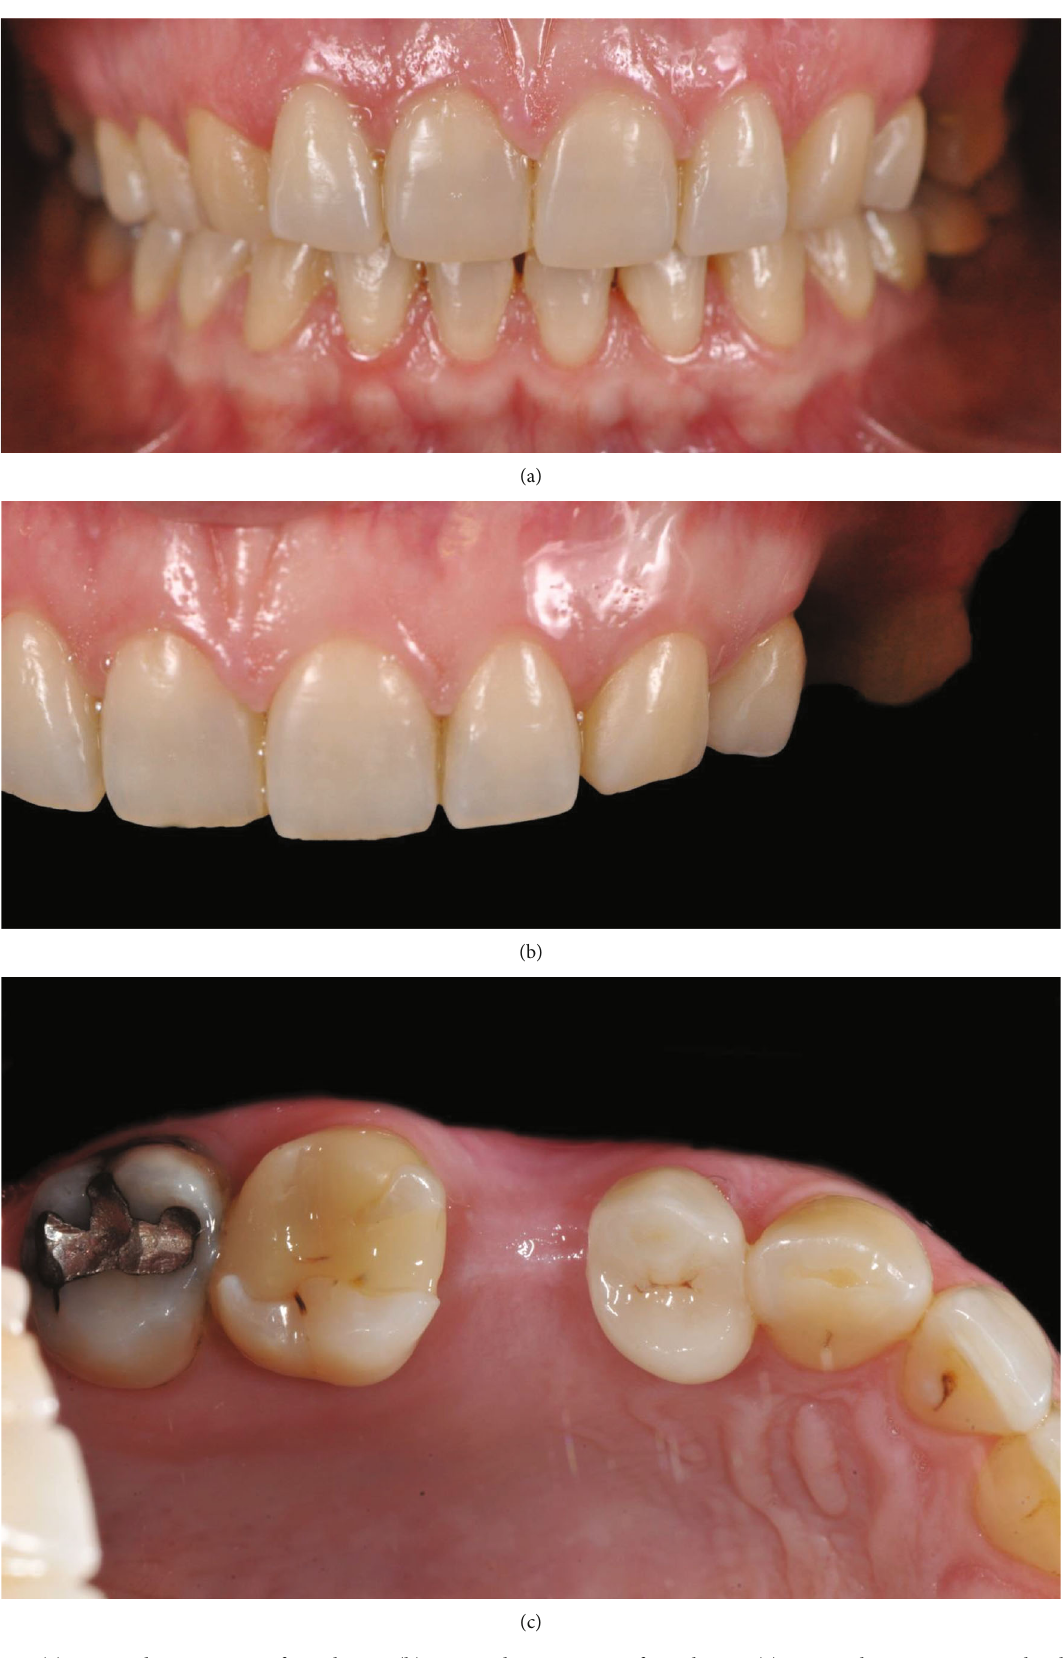
Figure 1: (a) Intraoral preoperatory frontal view. (b) Intraoral preoperatory frontal view. (c) Intraoral preoperatory occlusal